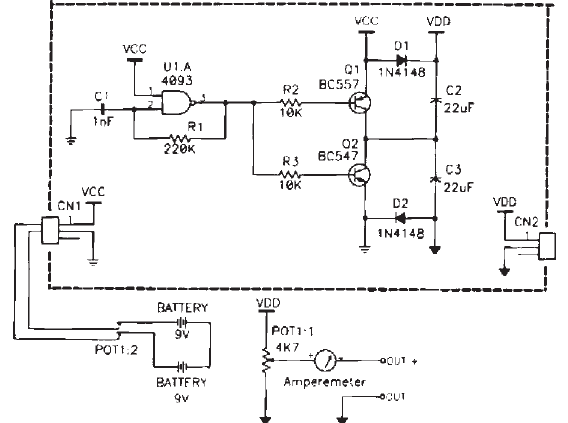
Figure 2 - Electronic diagram of the small iontophoresis device